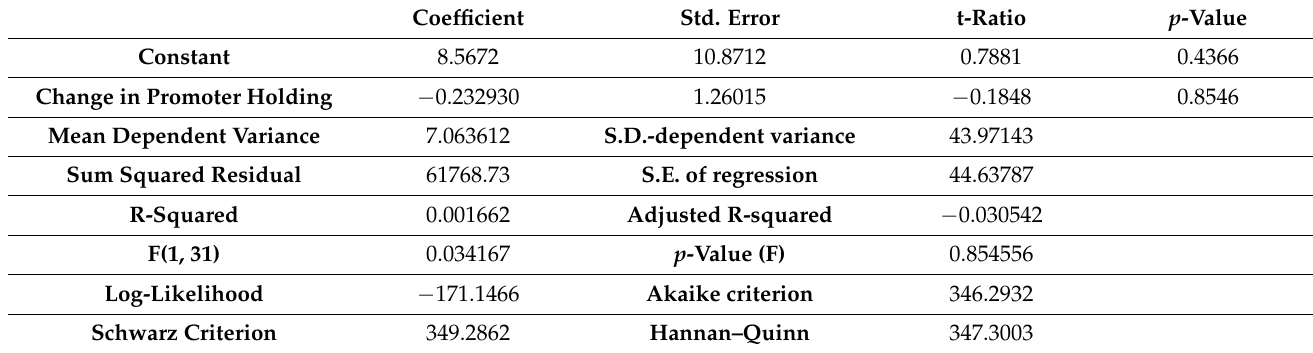
Table 7. Model 1: